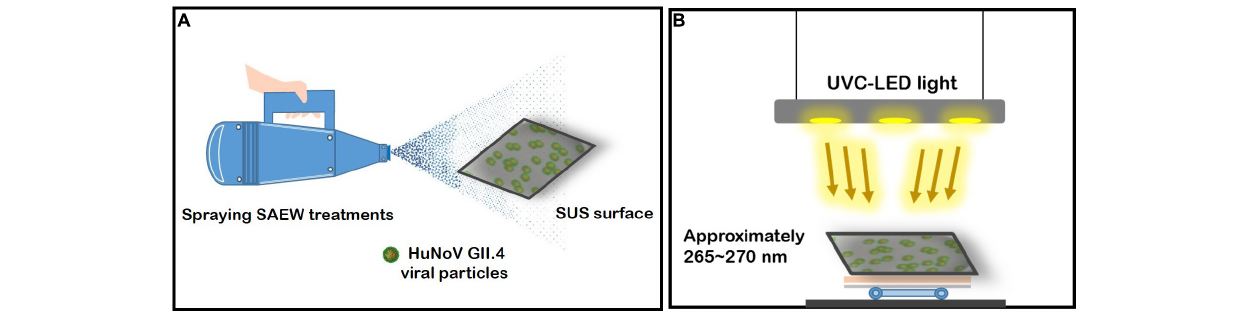
FIGURE 1 | Schematic representation of the experimental devices. (A) Spraying slightly acidic electrolyzed water (SAEW) treatment and ultraviolet C light-emitting diode (UVC-LED) irradiation system for norovirus (HuNoV), and (B) UV irradiation performance under UVC-LED